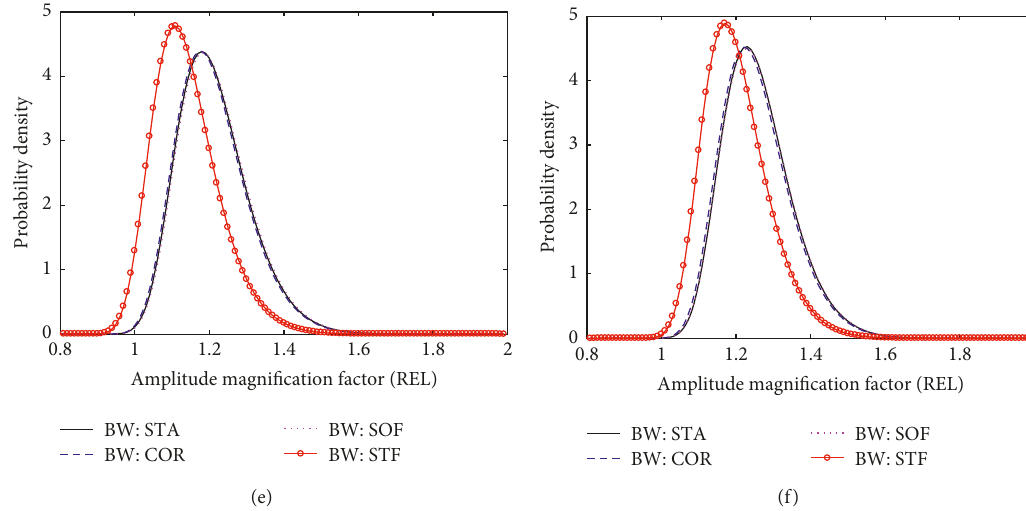
Figure 15: Probability densities versus relative AMF obtained by Monte Carlo simulation of 2000 mistuning patterns generated by uniform distribution of mean 0 and standard deviation 2.0% under the action of (a) 2EO, (b) 3EO, (c) 4EO, (d) 5EO, (e) 6EO, and (f) 7EO backward traveling wave